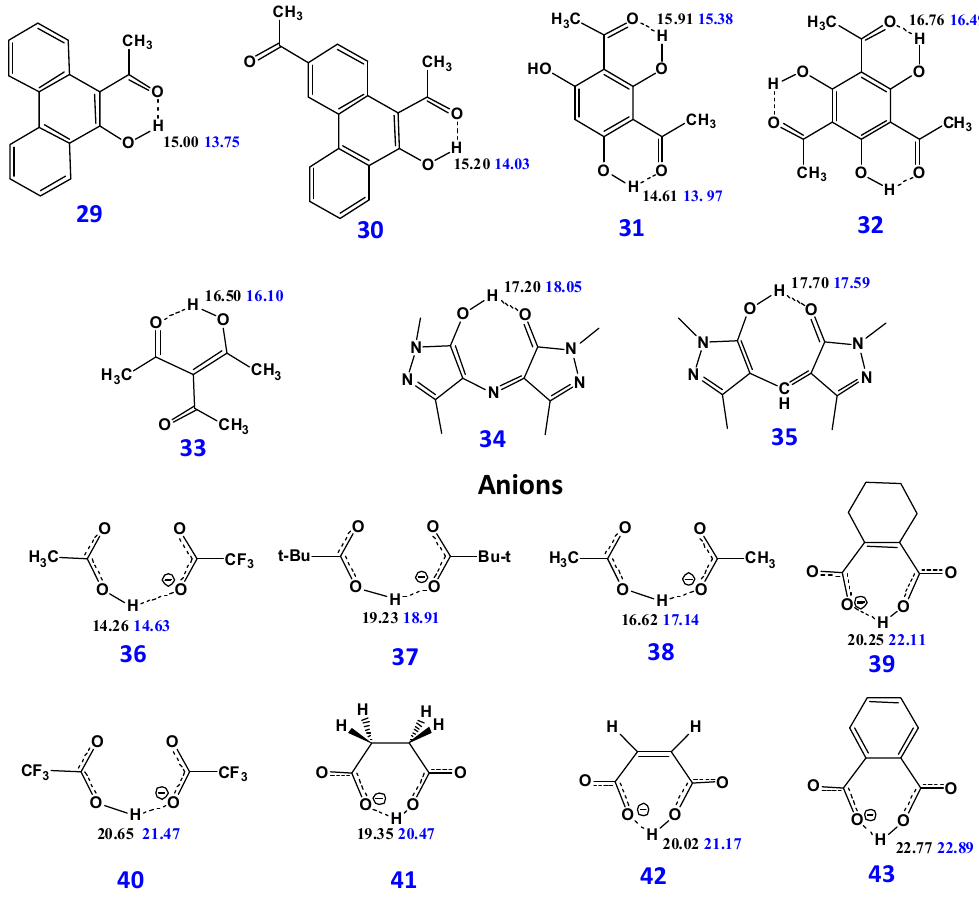
Figure 9. Chemical formulas of phenol compounds exhibiting intramolecular O–H ··· O hydrogen bonds and ionic complexes with intramolecular and intermolecular O–H ··· − O hydrogen bonds. The data in black and blue are the computed 1 H chemical shifts, ppm, with minimization of the structures at the B3LYP/6-31+G(d) and M06-2X/6-31+G(d) level of theory, respectively (see Table 1). Reprinted,